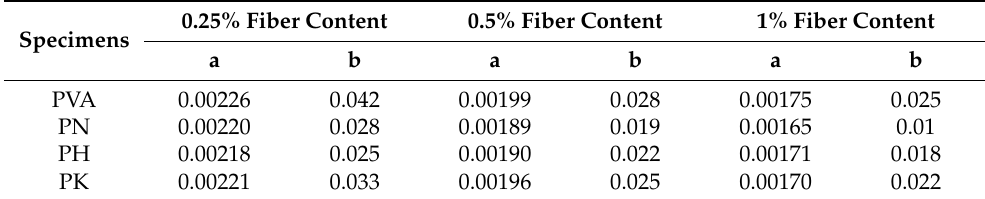
Figure 10. Crack propagation rates of cemented soil before and after modification with fiber content of 0.25% ( a ), 0.5% ( b ) and 1% ( c ). Table 6. Fitting parameters of crack propagation